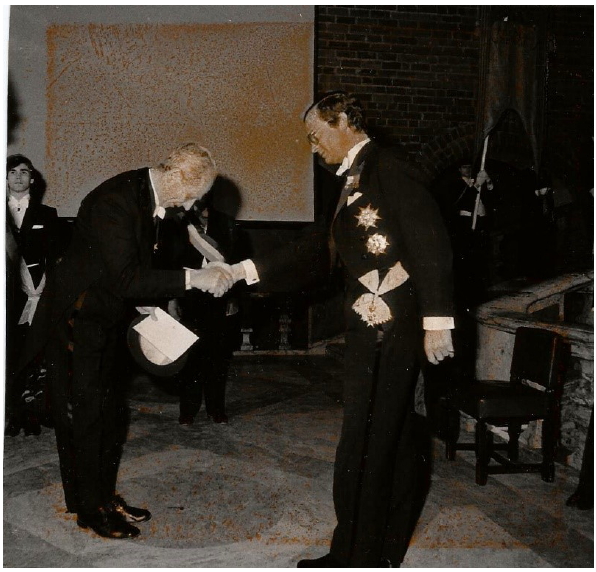
Fig. 1. Bjerhammar is awarded the KTH Great Prize in